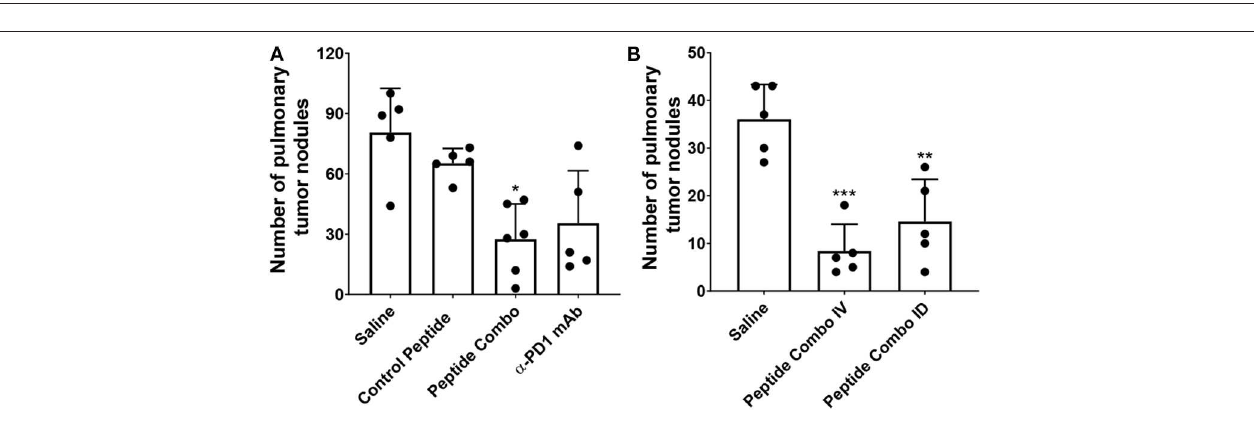
FIGURE 5 | Decreased tumor metastasis following treatment with PD1 peptide antagonists in a syngeneic model of B16-F10 mouse melanoma. (A) Mice ( n = 5–6) were injected IV with LacZ expressing B16 melanoma cells and treated IV with control peptide, PD1 peptide antagonists, or α -PD1 mAb. Control peptide is the myelin oligodendrocyte glycoprotein 35 − 55 . The pulmonary tumor nodules were counted on day 14. (B) Mice ( n = 5) were injected IV with LacZ-expressing B16 melanoma cells and treated either IV or ID with PD1 peptide antagonists. The pulmonary tumor nodules were counted at day 14. Data are expressed as the mean ± SD. Significant differences between control peptide and treated mice in (A) were determined using a one-way ANOVA multiple comparisons test, and the significance is denoted by * p < 0.05. Significant differences between saline and treated mice in (B) were determined using a one-way ANOVA multiple comparisons test, and the significance is denoted by ** p < 0.01 and *** p <